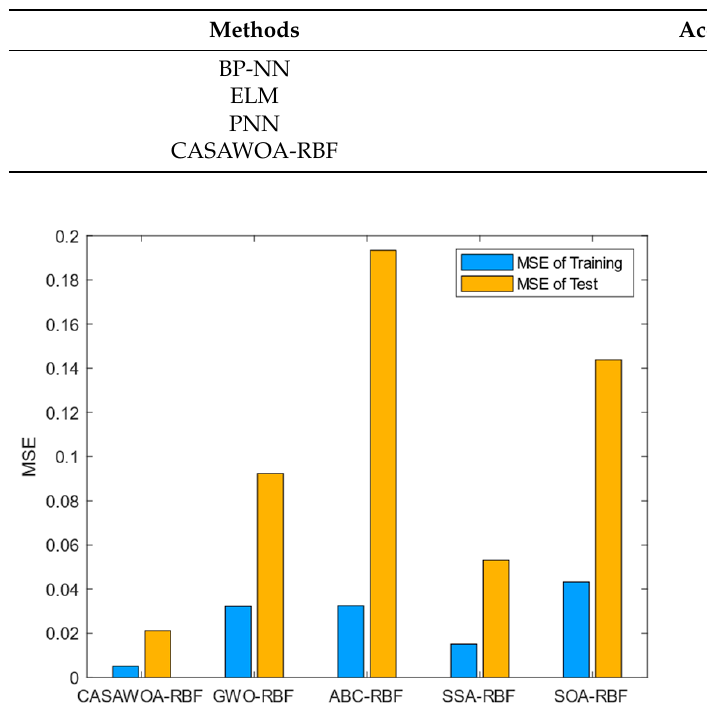
Table 10. The accuracy of each ANN-Based model.